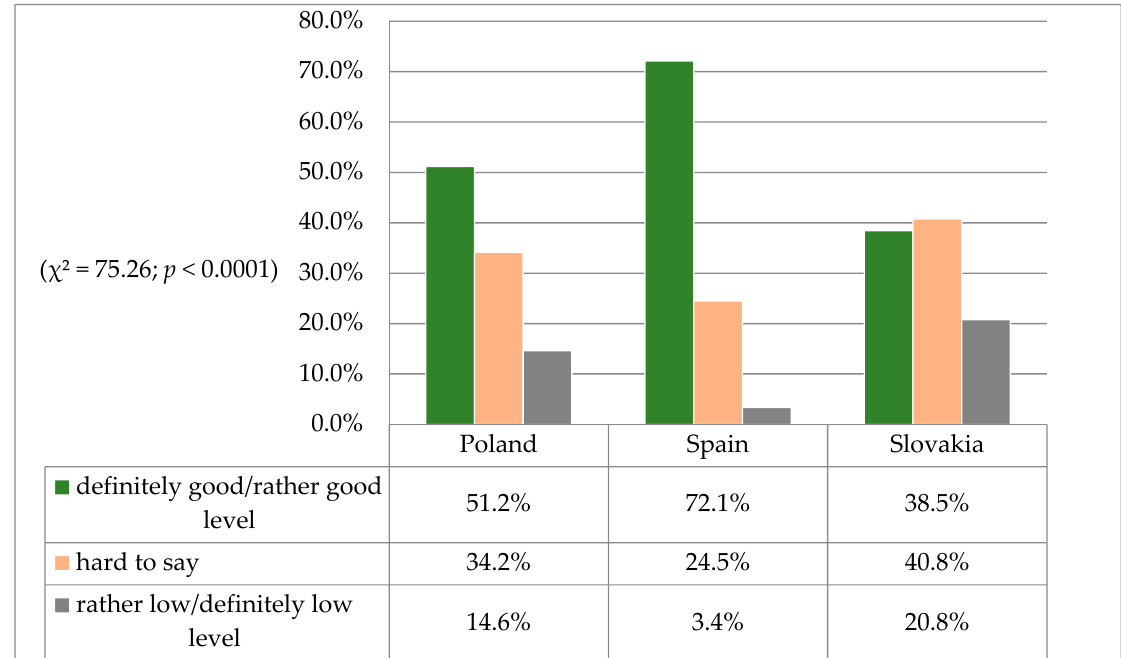
Figure 1. Observance of patients’ rights as perceived by nursing